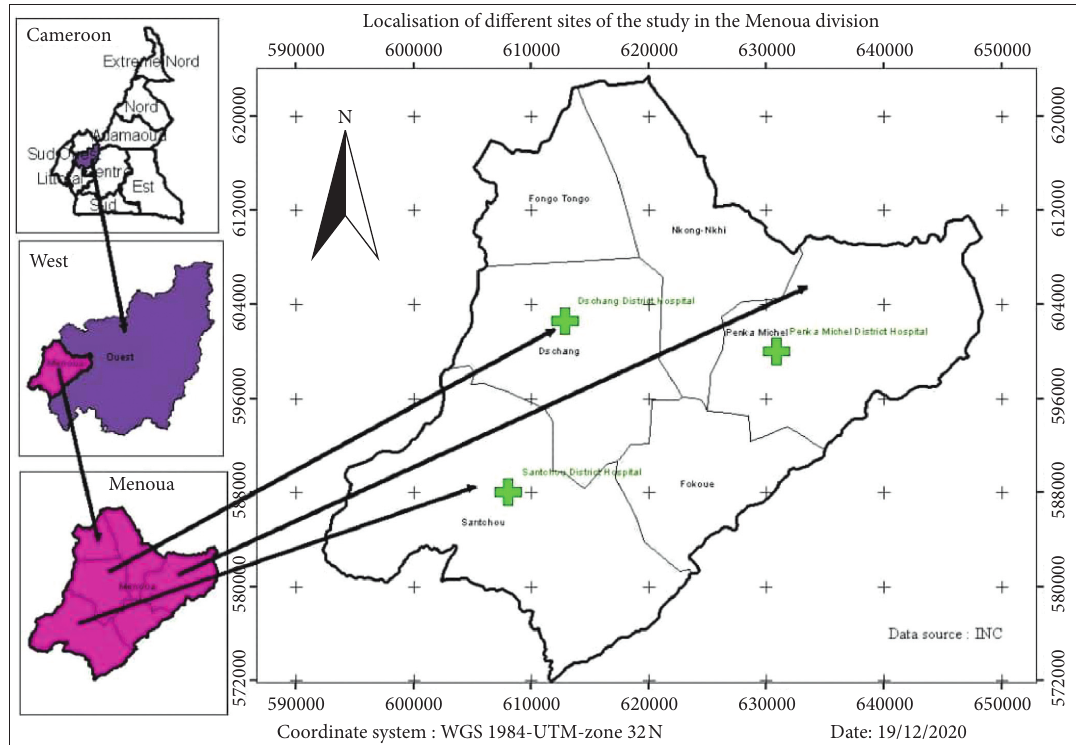
Figure 1: Sample collection location sites (A: Cameroon, B: West Region of Cameroon, and C: the six subdivisions of the Menoua division; turquoise circles represent study